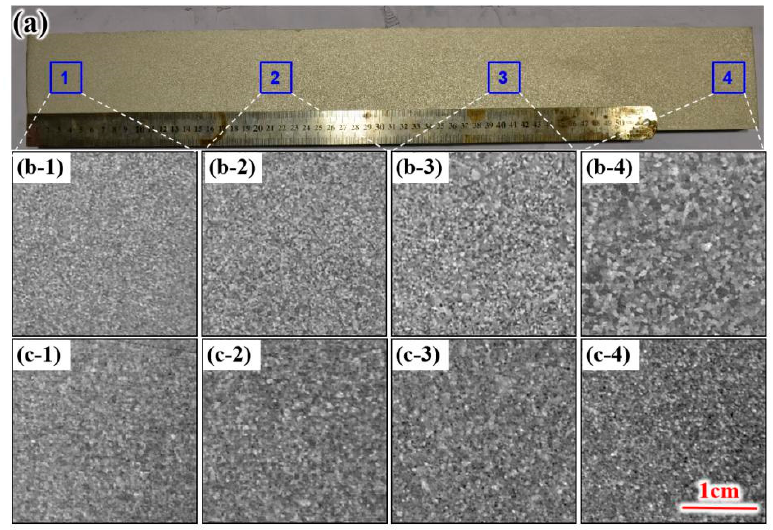
Figure 3. Macrostructure of the two ingots. ( a ) Macrospecimen, ( b ) ingot I, ( c ) ingot II.